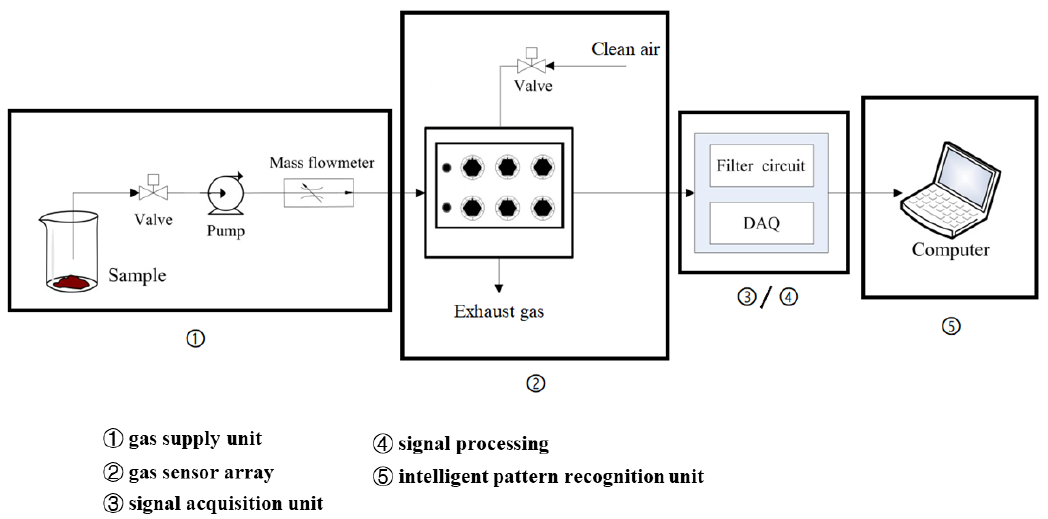
Figure 1. The schematic of the b-electronic nose system.